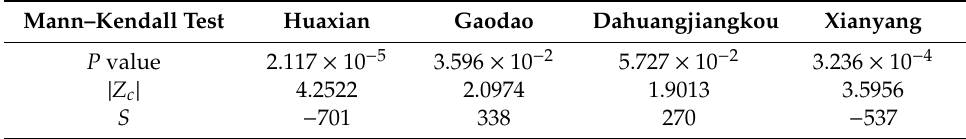
Table 2. Results of trend analysis for each station.